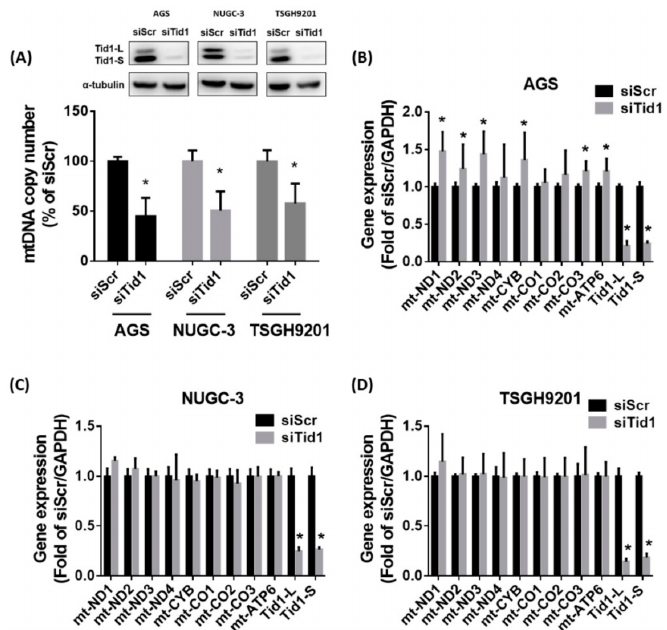
Figure 4. E ff ect of Tid1 knockdown on mtDNA copy number and mitochondrial gene expression of gastric cancer cells. ( A ) The e ff ect of Tid1 knockdown on mtDNA copy number was evaluated by real-time PCR. ( B – D ) The e ff ect of Tid1 knockdown on mitochondrial gene expression was evaluated by reverse transcription (RT)-real-time PCR in the ( B ) AGS, ( C ) NUGC-3, and ( D ) TSGH 9201 gastric cancer cells. The e ffi ciency of Tid1 knockdown was confirmed by Western blot or RT-real-time PCR. Data are shown as the mean ± SD of at least three independent experiments. *, p < 0.05, compared with the siRNA for scramble (siScr) control group.